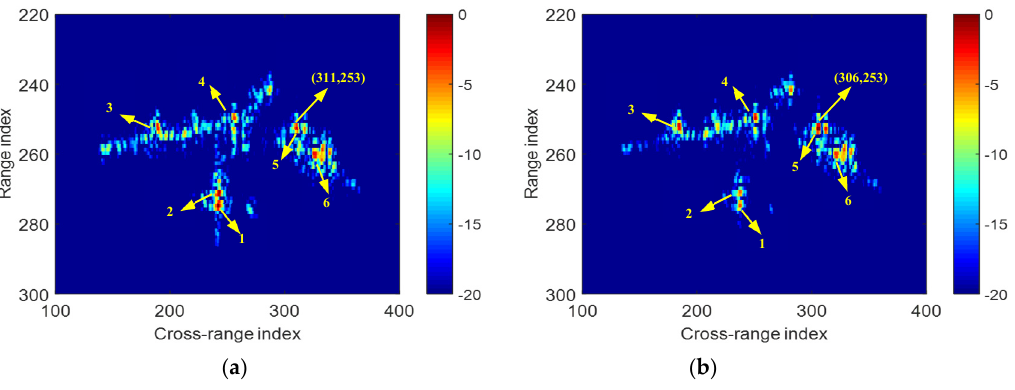
Figure 12. The ISAR images of A380 model. ( a ) Channel R2. ( b ) Channel R3.